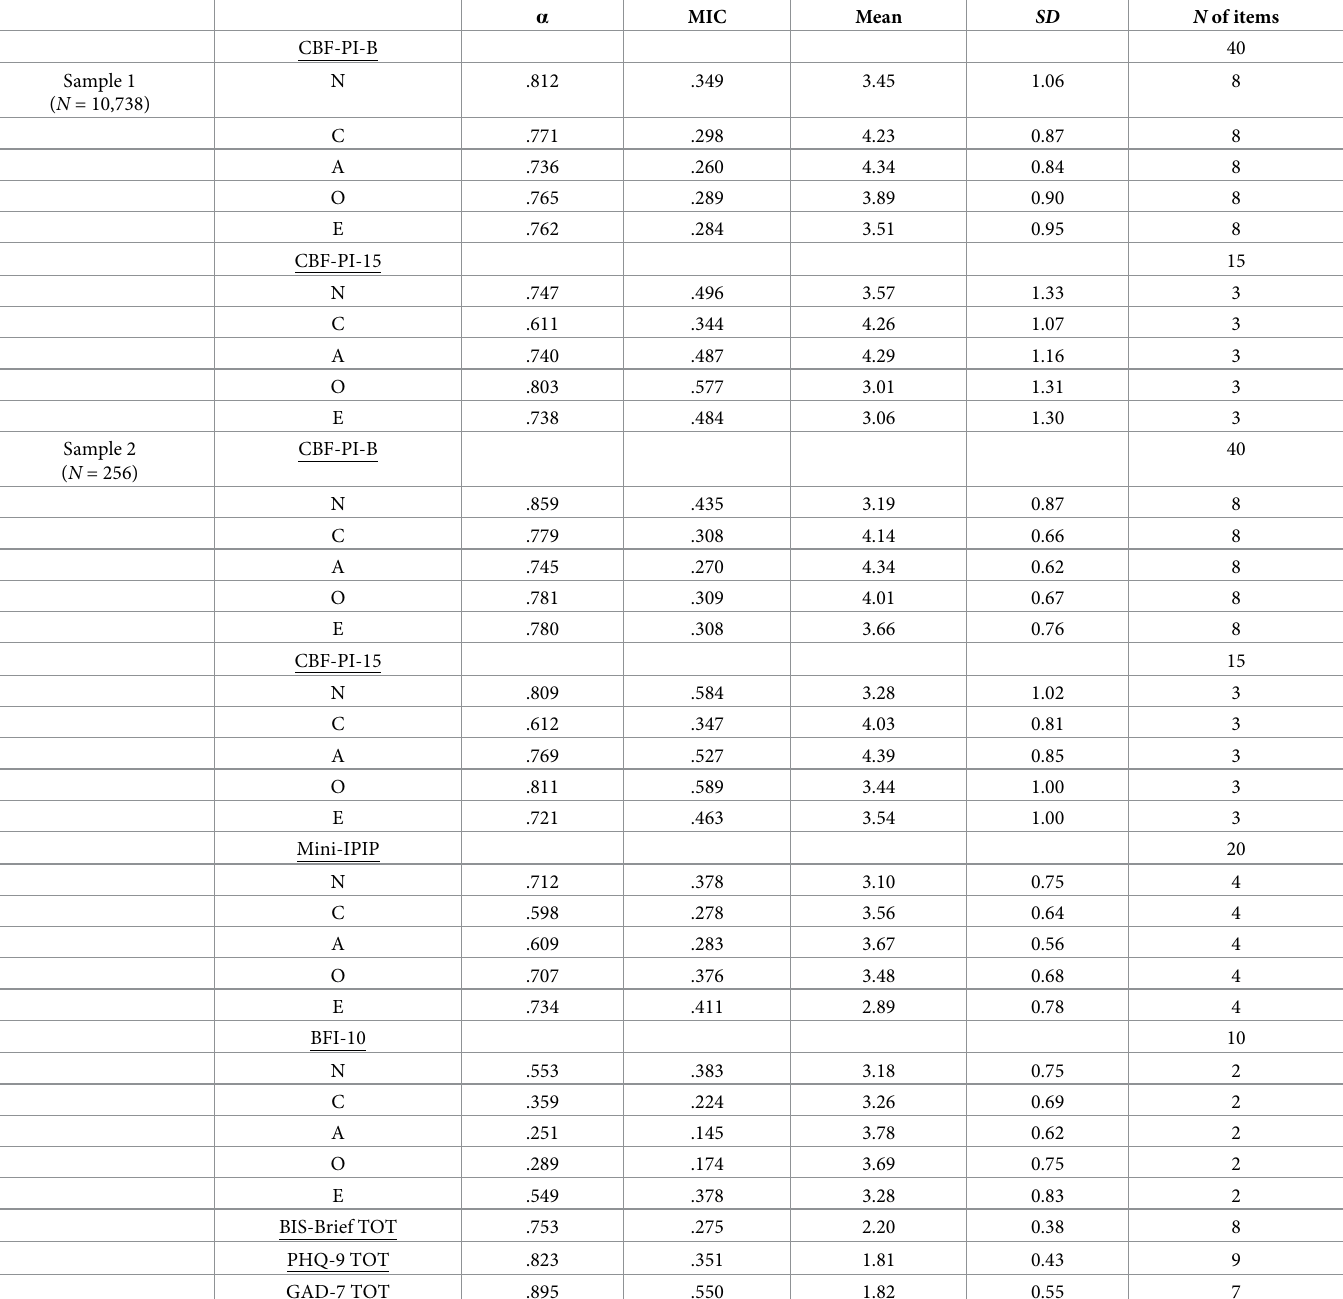
Table 1. Descriptive statistics for all scales in the current study. α MIC Mean SD N of items CBF-PI-B 40 Sample 1 ( N =